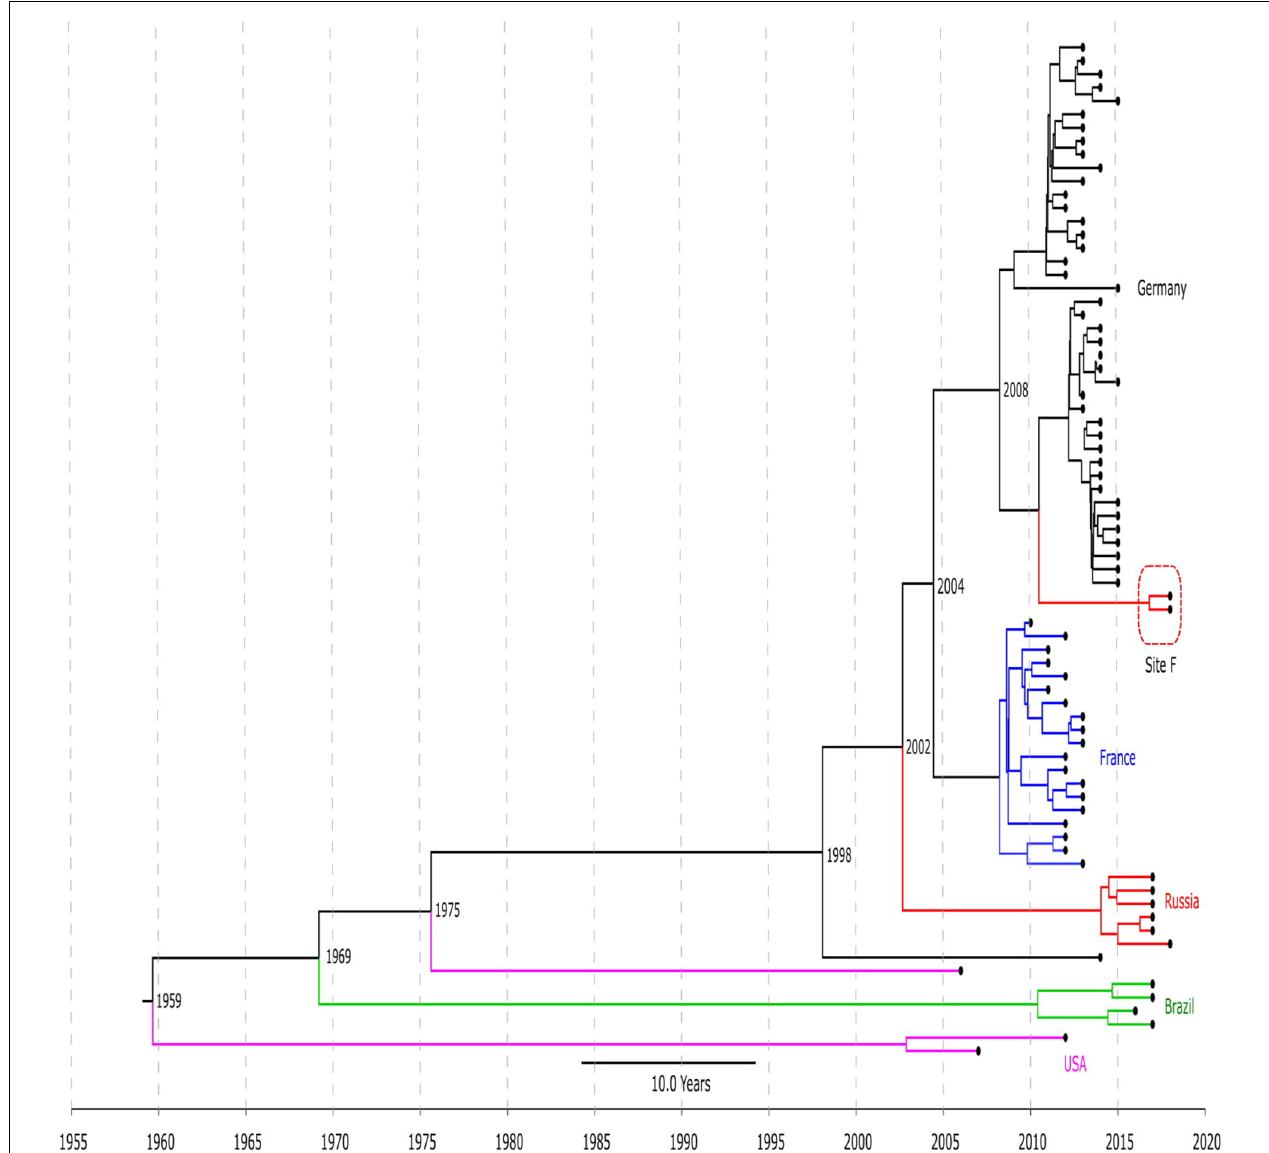
FIGURE 2 | Chronogram of LRSE ST2 ( n = 76) based on core-SNP alignment and BEAST. Color of branches is matched to country of origin of LRSE: black, Germany; blue, France; green, Brazil, violet, United States; and red, Russia (sites E and F). The time of divergence is given near nodes.